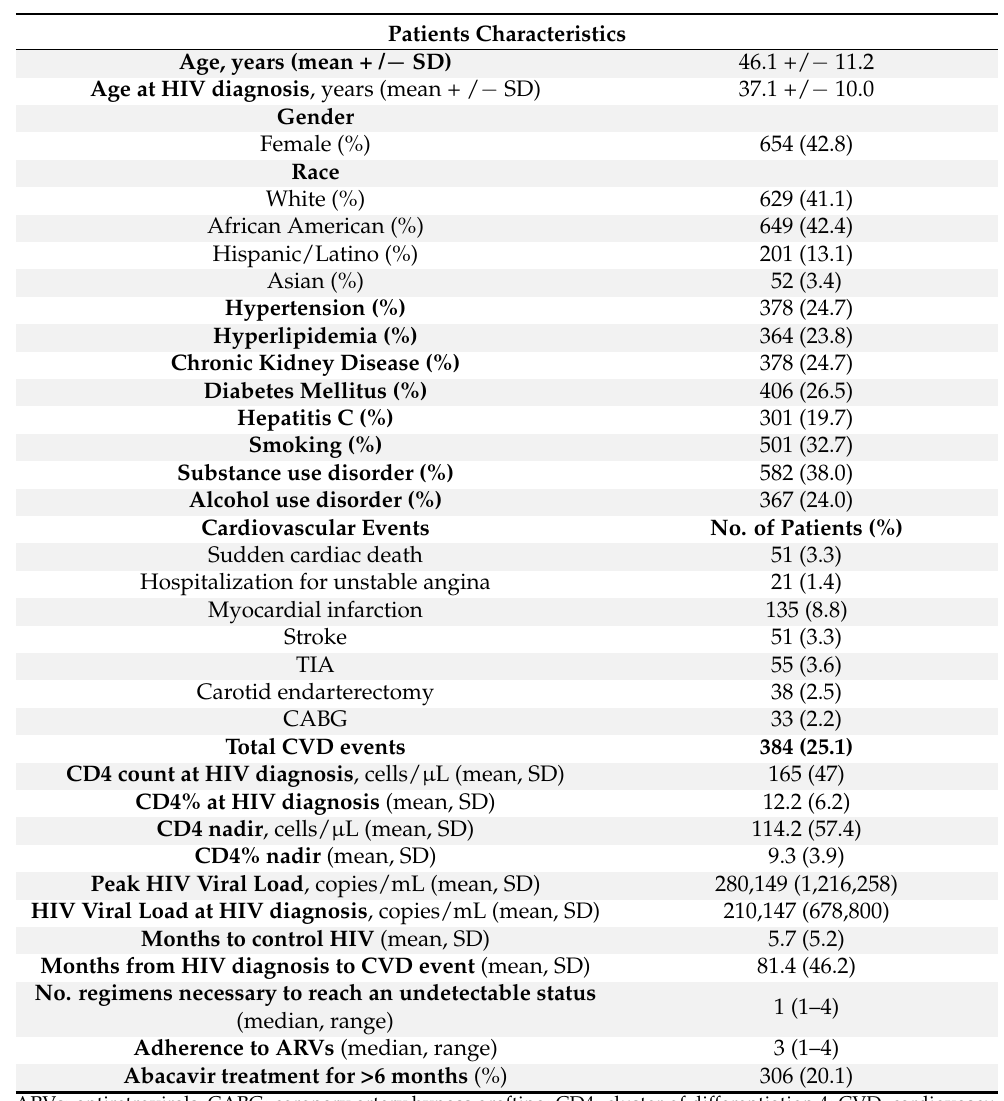
Table 1. Demographic, clinical, and laboratory characteristics of patients included in the development cohort ( n =